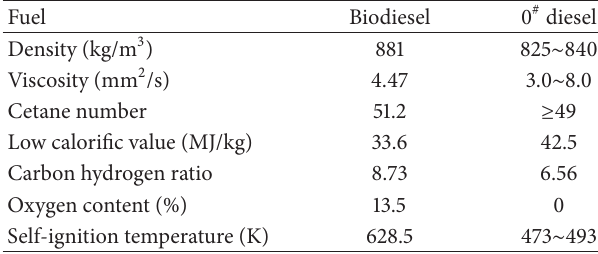
Table 1: Physical and chemical properties of biodiesel and diesel.